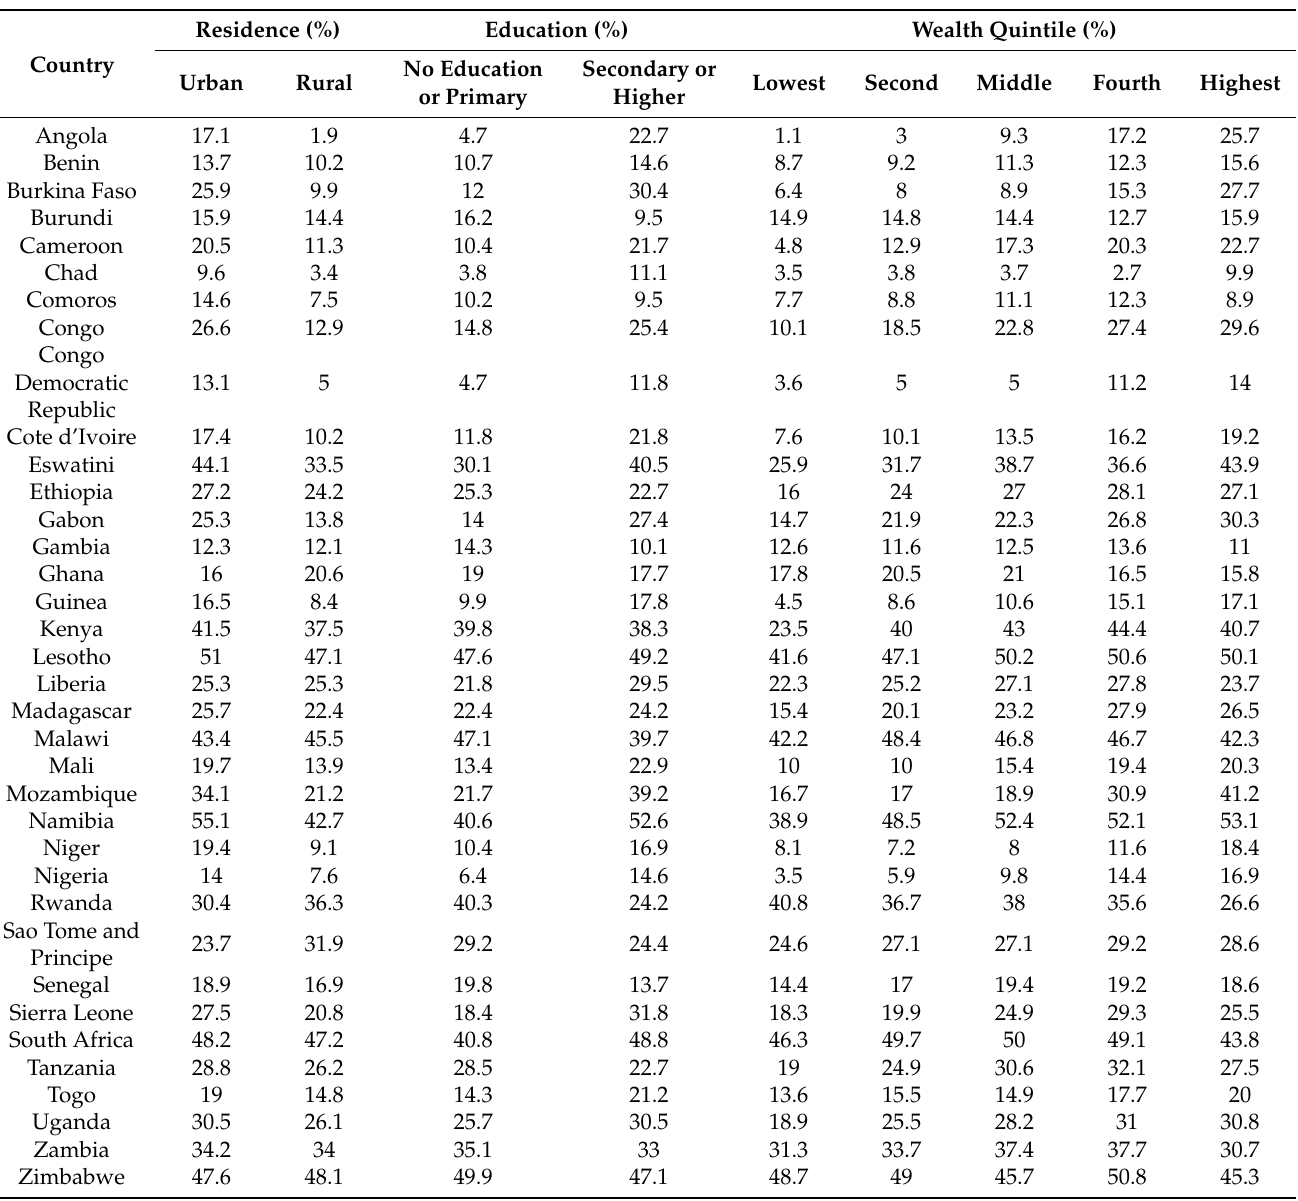
Table 2. Distribution of current use of any modern method of contraception (all women) in sub- Saharan